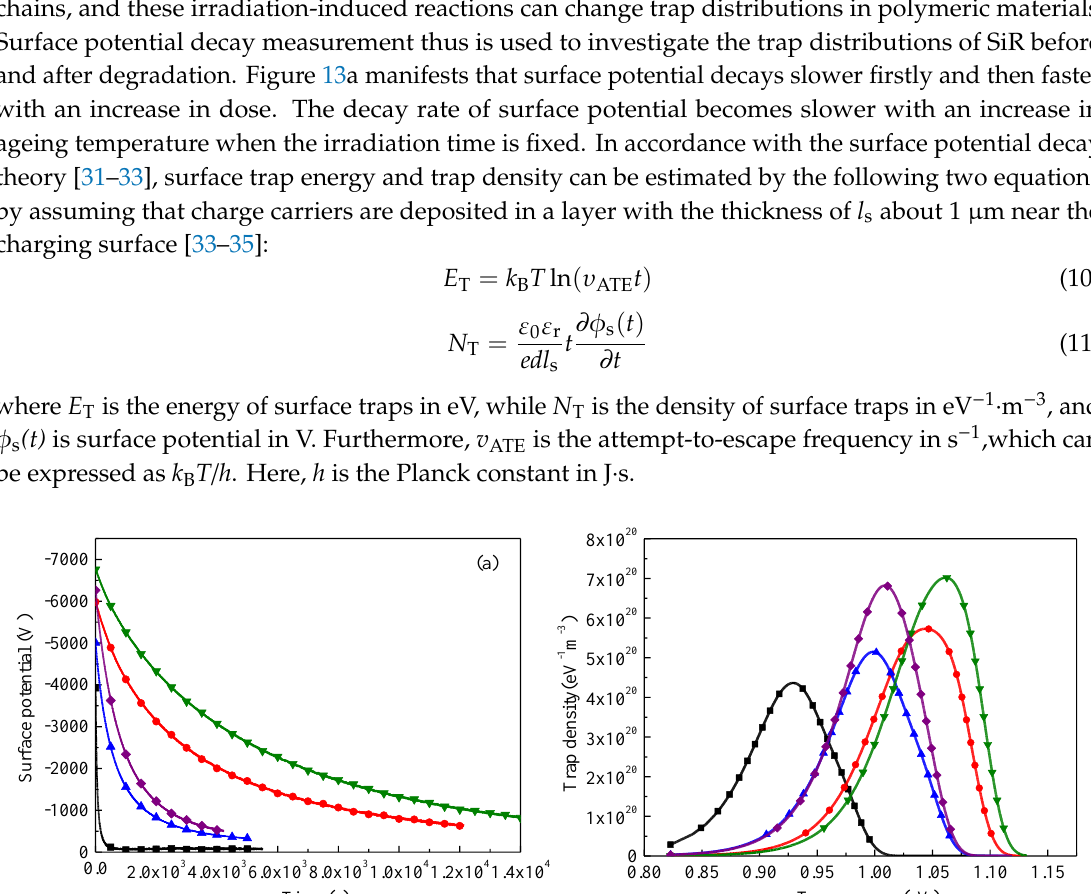
Figure 13. ( a ) Surface potentials of pristine and degraded SiR samples as a function of time, ( b ) trap distributions calculated by Equations (10) and (11). : Pristine SiR, : irradiated at 145 °C for 900 h, : irradiated at 145 °C for 1500 h, : irradiated at 185 °C for 900 h, : irradiated at 185 °C for 1500 h.